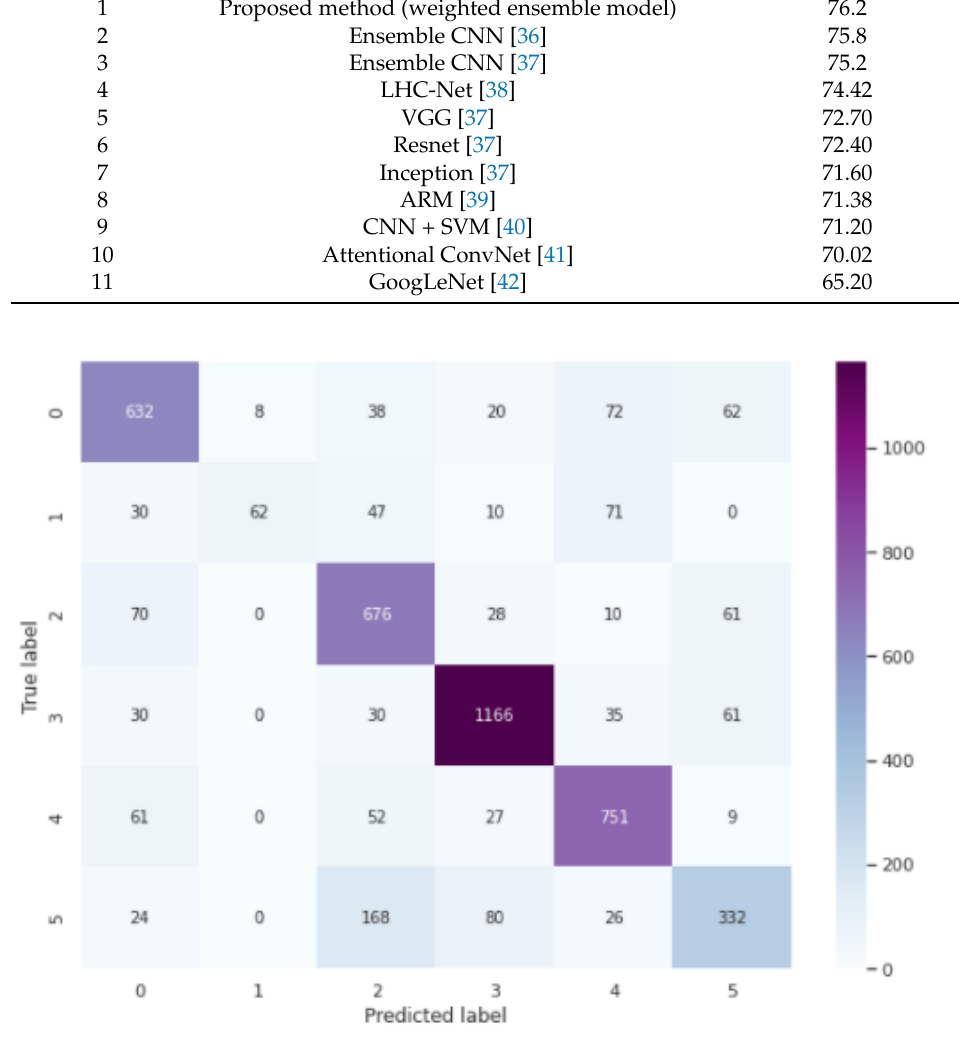
Figure 4. Confusion matrix on the FER-2013 dataset.